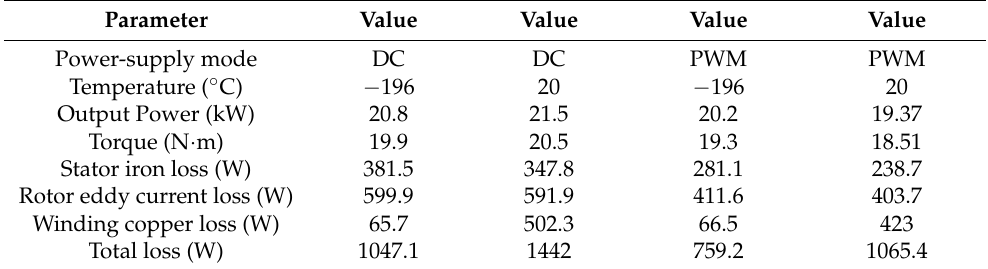
Table 2. Motor-loss data under different power-supply modes and different temperatures.